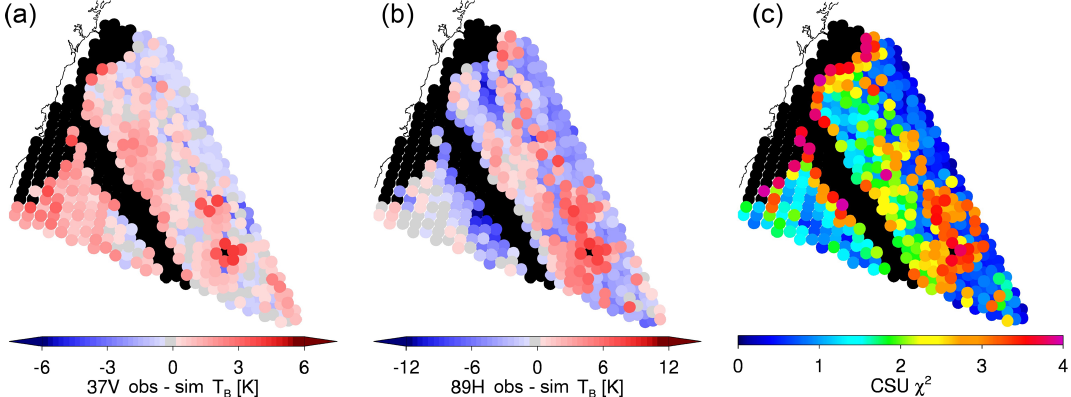
Figure 11. The same scene as Fig. 8, showing the difference of observed and simulated radiances, specifically at 37V (a) and 89H (b) channels, and quality of fit (c) . Black signifies pixels that did not